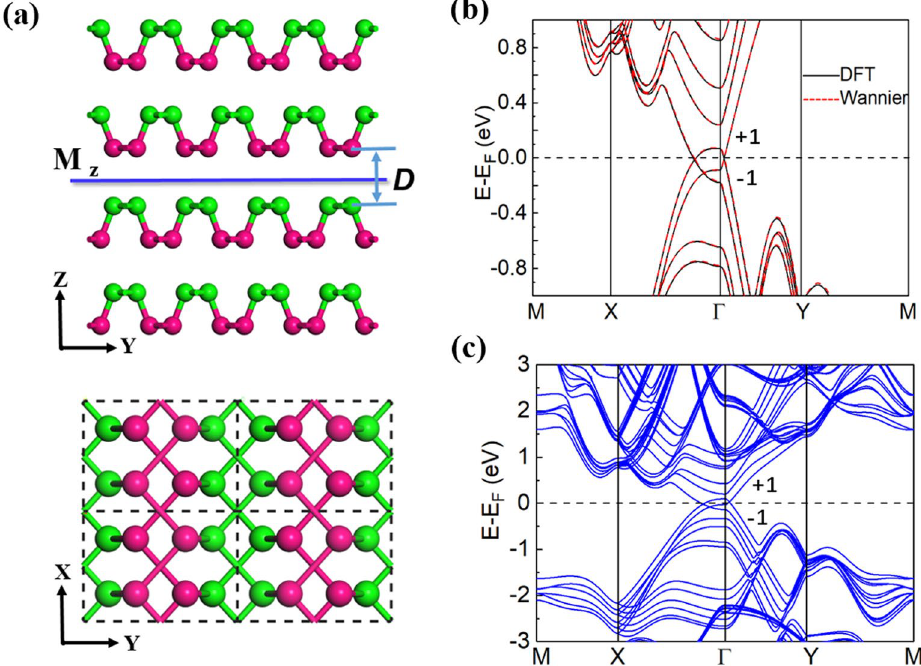
Figure 5. ( a ) Side and top views of the crystal structure of the 4-layer BP. ( b ) Band structures of the 4-layer BP under a 3.5% compressive strain, obtained from DFT (black solid curves) and Wannier interpretation (red dotted curves) calculations. The bands around the E F can be assigned with mirror eigenvalues of ± 1. ( c ) Band structure for the 6-layer BP film under a 2.5% compressive strain. The mirror eigenvalues ± 1 are also illustrated for the bands around the E F